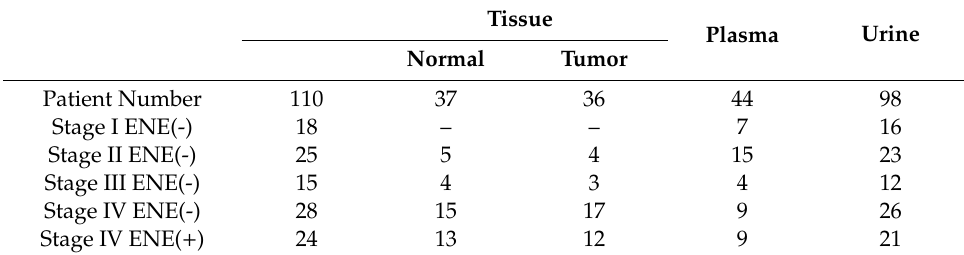
Table 1. Clinical characteristics of the study (N = 110).